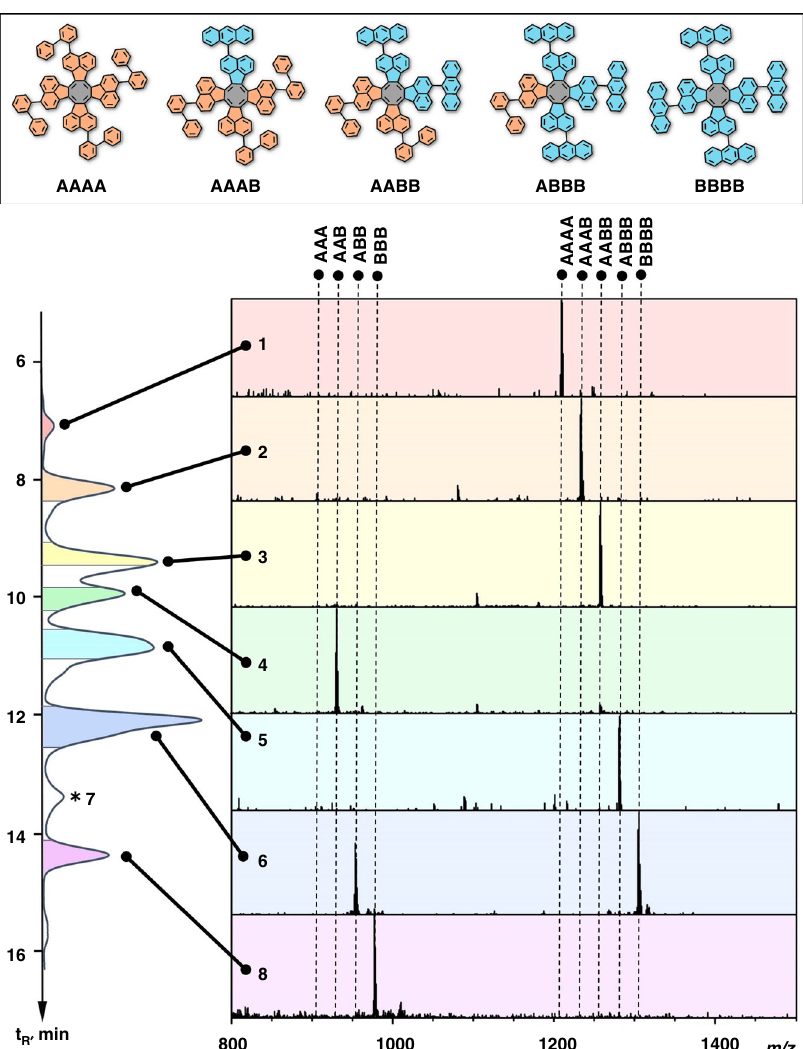
Fig. 6 HPLC/MS analysis of the combinatorial cyclotetramerization of segments A and B (1:2 ratio). Fractions 1, 2, 4, 5 and 8 contain individual precursor molecules AAAA , AAAB , AAB , ABBB and BBB respectively. Fraction 3 contains both isomers for the (10,6) chirality ( AABB and ABAB ). The molecular structure is given for only one isomer A2B2 (AABB) . Fraction 6 contains the trimer ABB and the tetramer BBBB ; Fraction 7 (marked with asterisk) contains the mixture of several hexamers. HPLC separation is performed on COSMOSIL-PBr column 4.6 × 250 (eluent DCM/MeOH 4:1, fl ow rate 1 mLmin − 1 , t = 35 °C, detection at 380